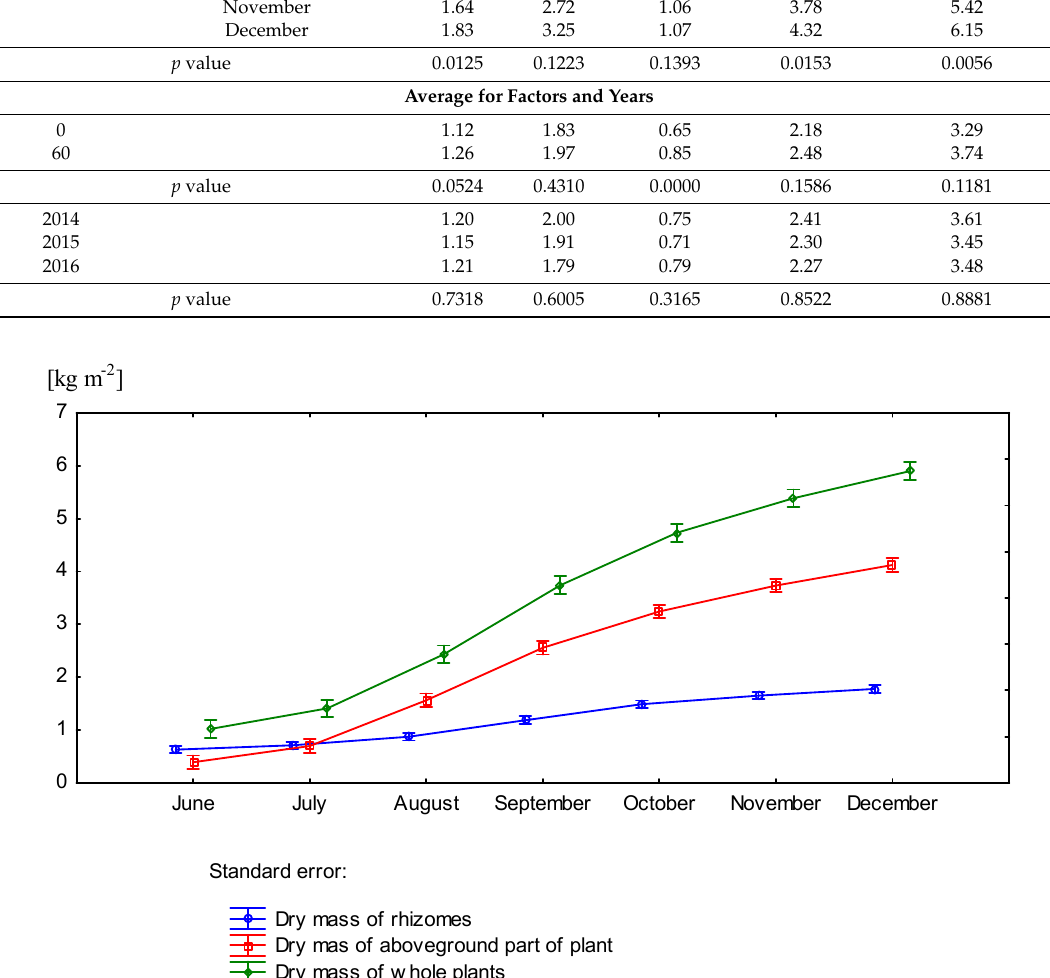
Figure 8. Dry mass yield of the rhizomes and the aboveground part of the plant during the vegetation period of the years 2014–2016 (average for years).